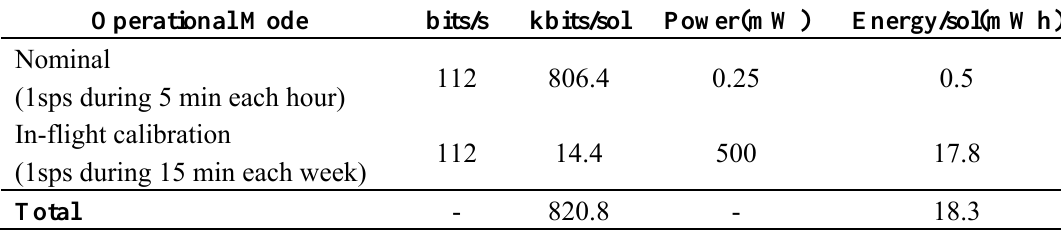
Table 5. GTS data production and power